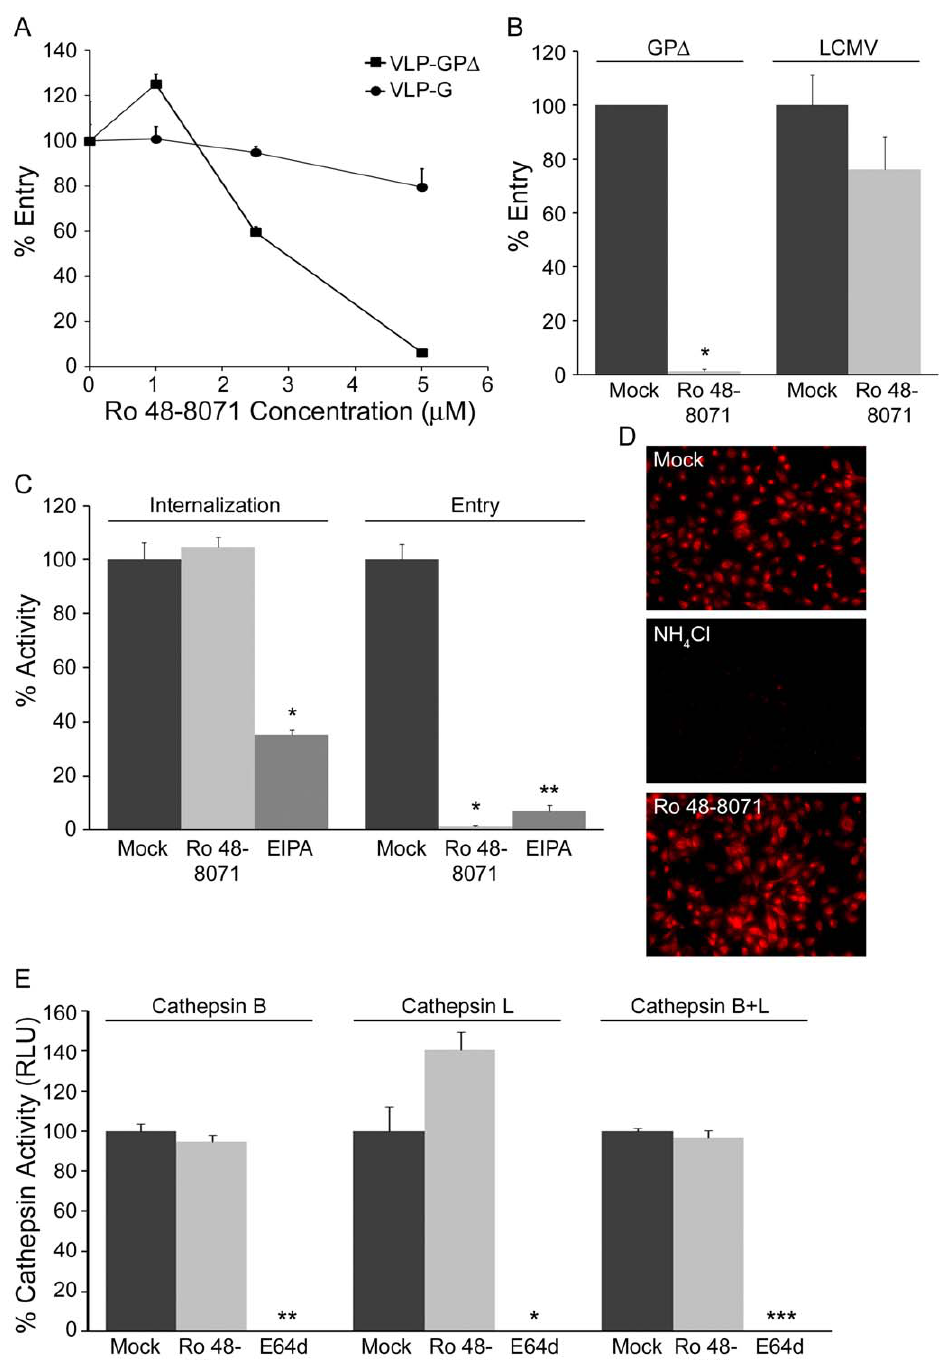
Figure 3. Ro 48-8071 inhibits EBOV entry at a post internalization step and does not inhibit endosome acidification or cathepsin levels. Effects of Ro 48-8071 (indicated concentration in A, 5 m M in B-E) on: (A) VLP-GP D and VLP-G entry; one representative of two experiments (done in triplicate). (B) VLP-GP D and VLP-LCMV entry; one representative of three experiments (done in duplicate). (C) VLP-GP D internalization and entry; 50 m M EIPA was used as the positive control for an inhibitor of EBOV internalization [8]; 10 m M EIPA was used as the control for the entry assay (50 m M EIPA caused high background fluorescence in the entry assay); one representative of two experiments (done in triplicate). (D) Low endosomal pH was detected by incubating cells with Lysotracker Red; 10 mM NH 4 Cl was used as the control for pH neutralization; representative images from multiple coverslips from a single experiment. (E) Cathepsin B, L, and combined B/L activity; 10 m M E64d was used as the positive control for inhibition of cysteine protease activity; results from a single experiment performed in duplicate. In all assays, SNB19 cells were pre-treated with the indicated concentration of inhibitor for 1 hr at 37 u C, and inhibitors were maintained throughout the assays. Error bars represent standard deviation from the mean of mock-treated samples: * (P , .01), ** (P , .001), or *** (P , .0001).